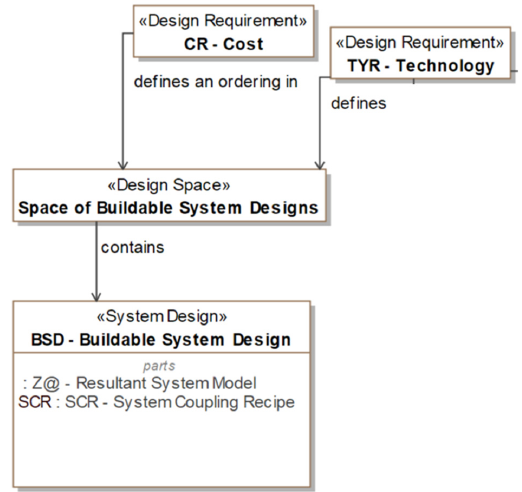
Figure 6. A description of the T3SD Buildable Perspective showing the buildable designs are defined based on required technology and ordered according to preferred cost of the